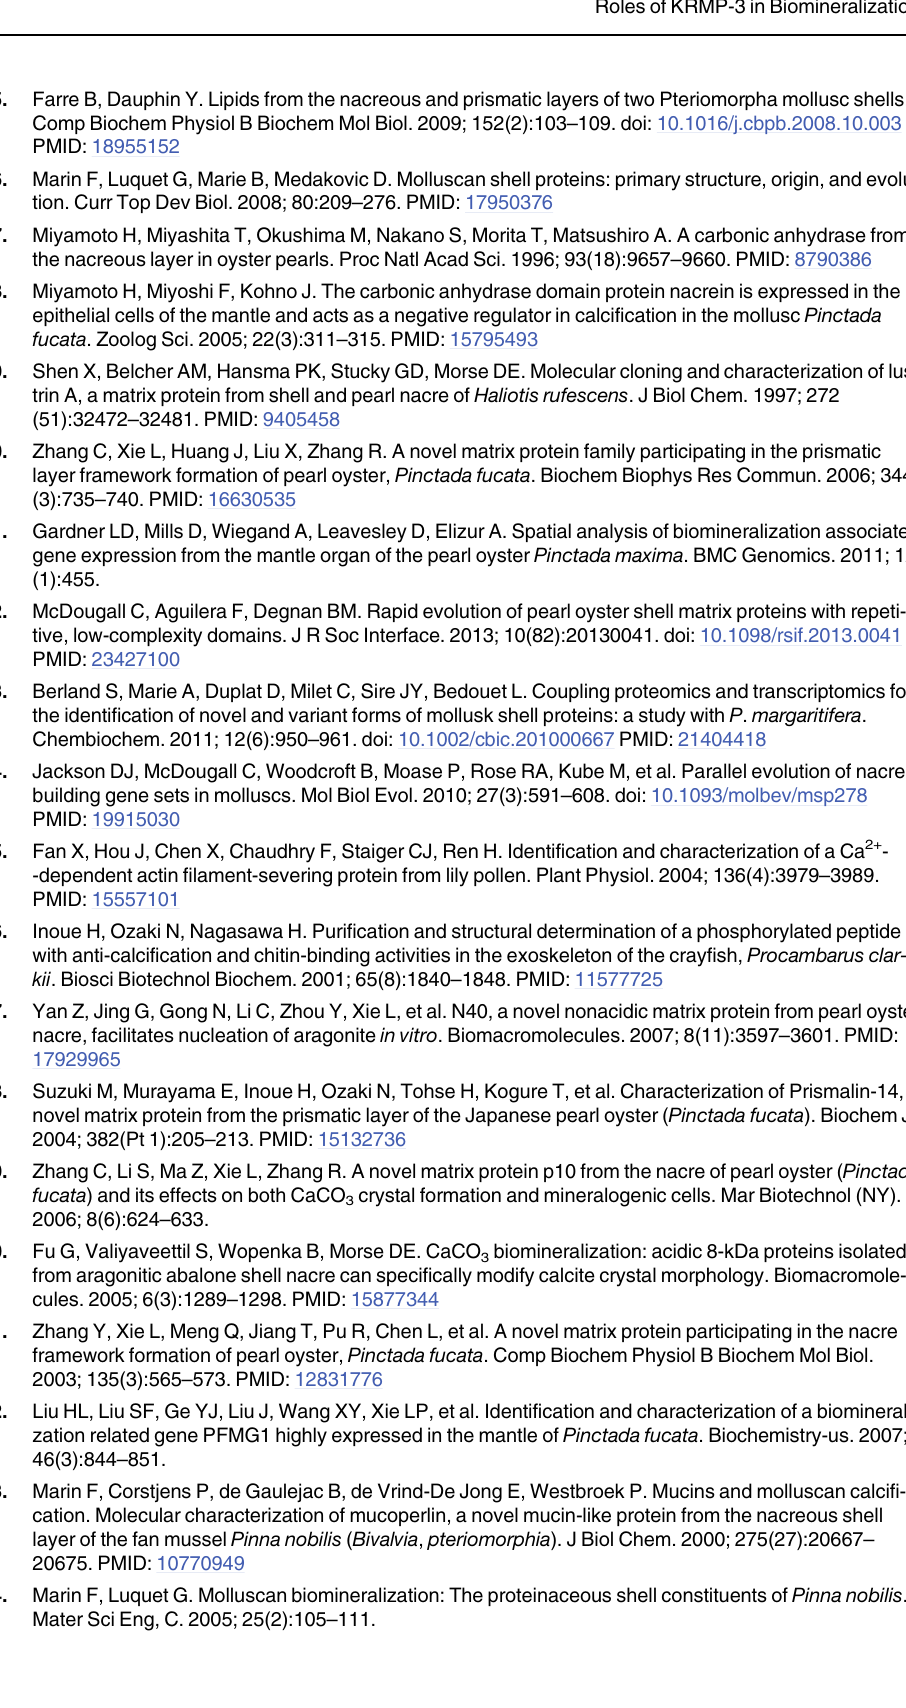
PLOS ONE | DOI:10.1371/journal.pone.0131868 July 10,